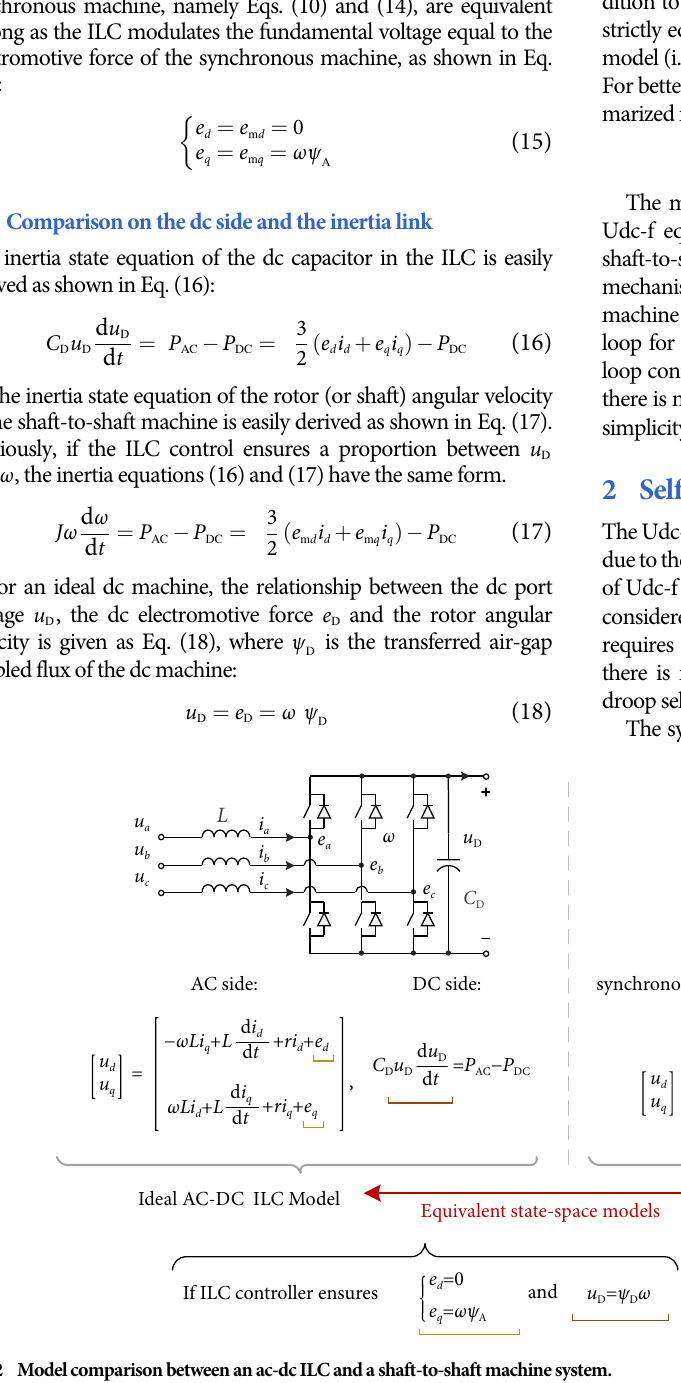
Fig. 2 Model comparison between an ac-dc ILC and a shaft-to-shaft machine